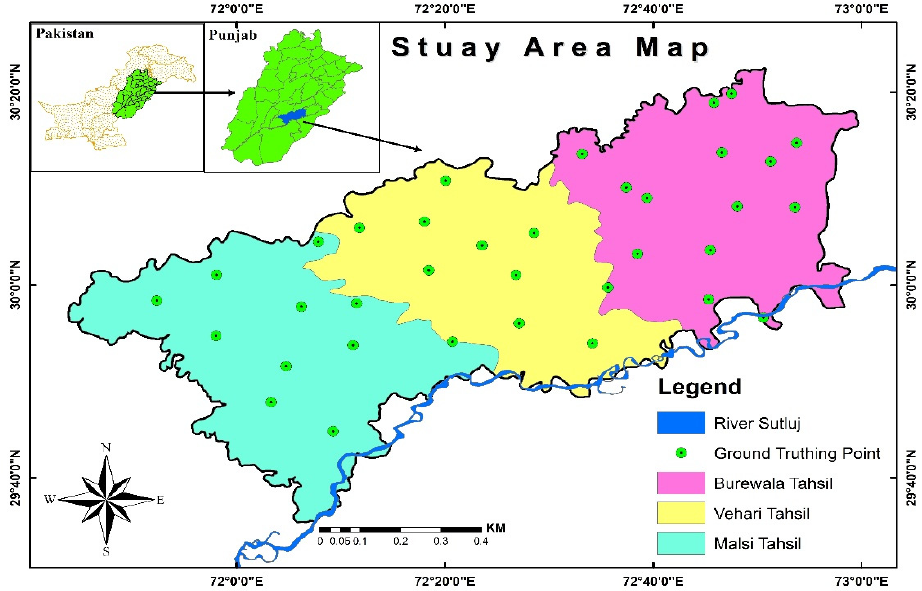
Figure 1. Geographical location of study area (Vehari).